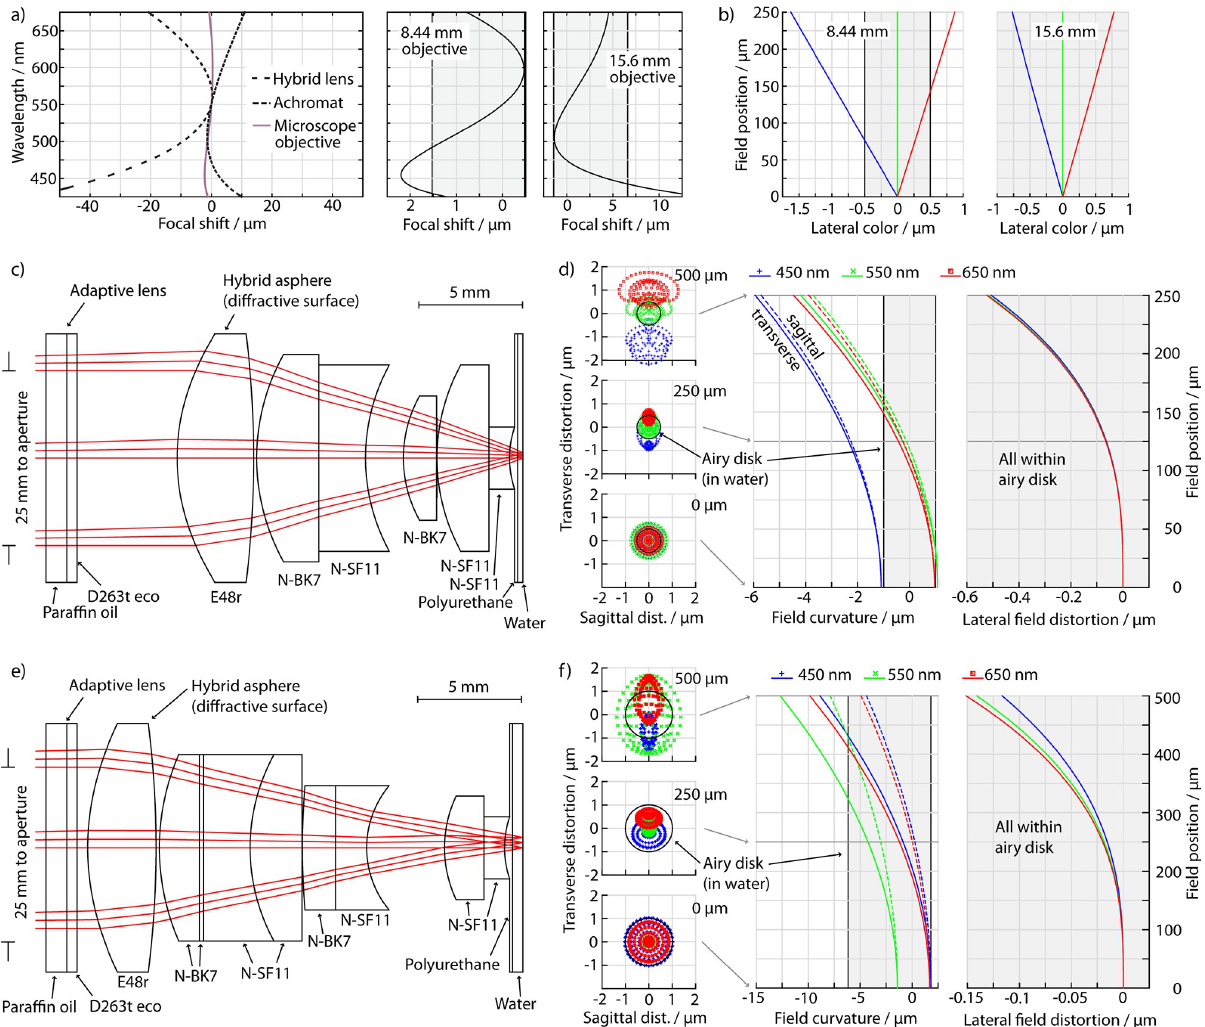
Fig 2. Optical simulations. Top row: a) Chromatic focal shift of a 9mm diffractive and dispersive achromat and the 8.44mm objective, focal shift of the 8.44 and 15.6mm objectives. (b) Lateral chromatic distortion for three wavelengths. Center row: c) layout and d) ray tracing of the 8.44mm objective, spot diagrams at three field positions, field curvature and field (image) distortion. Bottom: 15.6mm objective. The shaded areas indicate the Airy disk or equivalent axial positions. All simulations are reverse, so the image in the simulation corresponds to the perceived image.